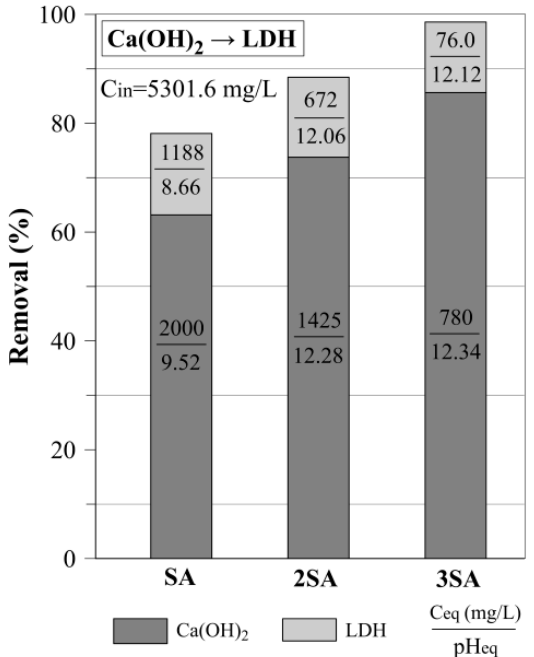
Figure 5. Sulfate removal in two-step treatment method (precipitation with calcium hydroxide (Ca(OH) 2 ) and subsequent removal of residual sulfate by LDH (dosage 5g / L) in the function of Ca(OH) 2 dosage.